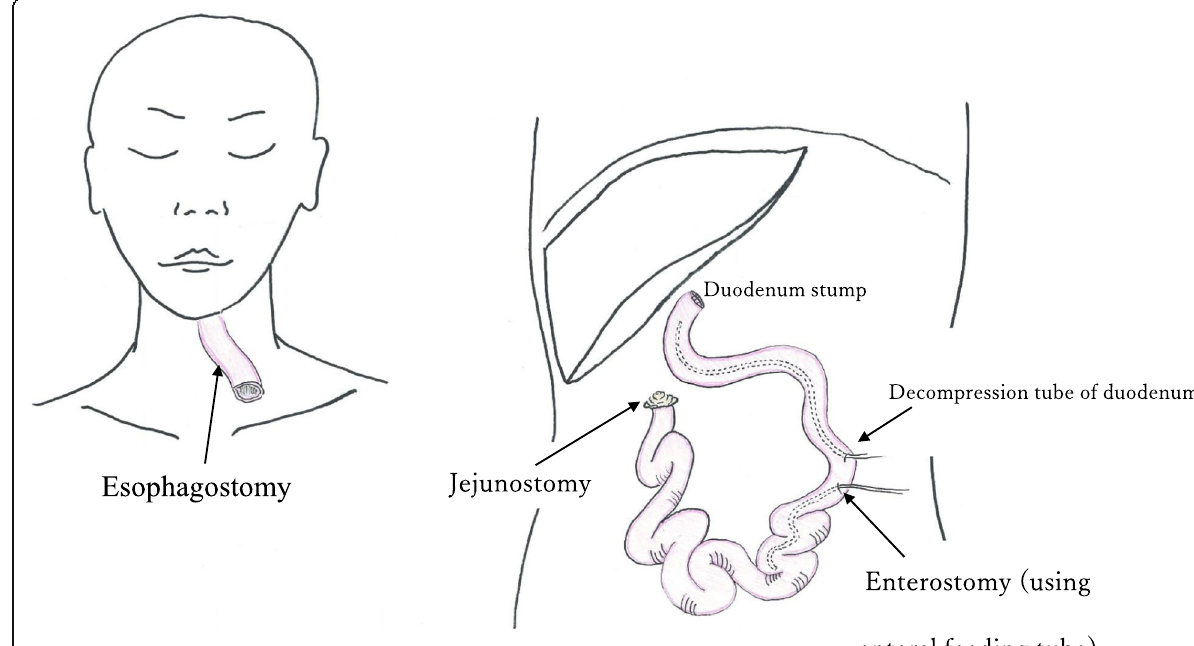
Fig. 6 An outline of the reconstruction in the second operation. Esophagostomy, jejunostomy, and enterostomy for nutrition were performed. The length of the remnant jejunum was 1 m and 80